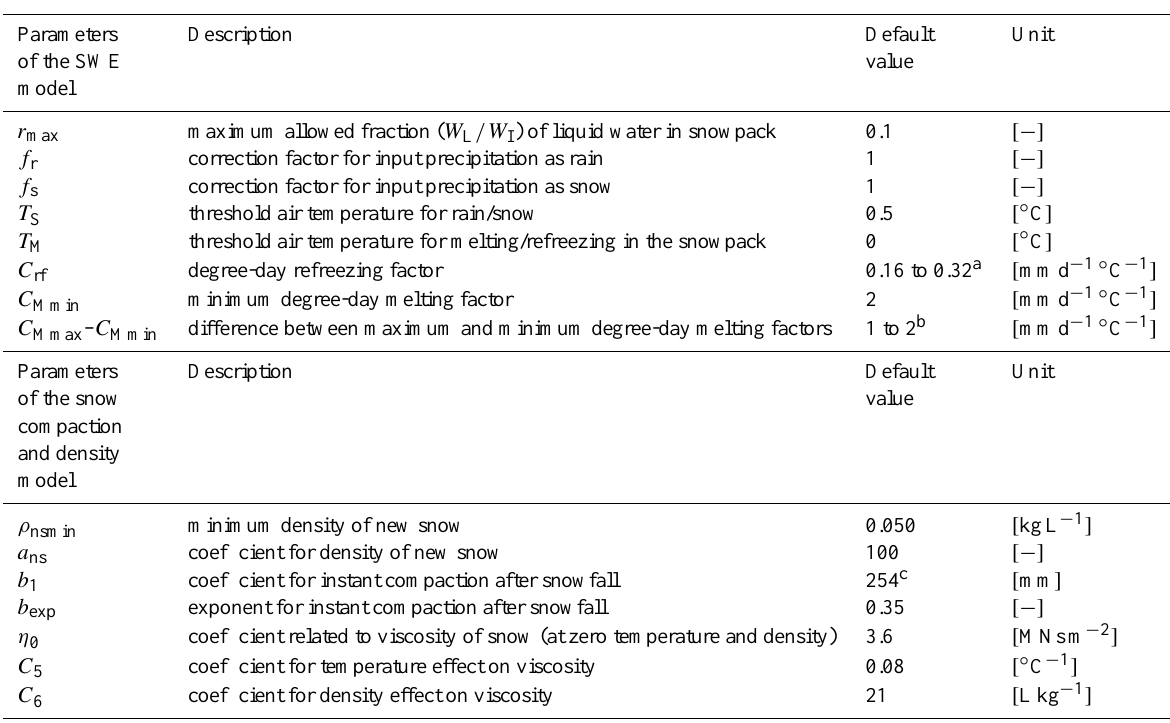
Table 1. The 15 seNorge snow model parameters with their default values and units. The values have been set on the basis of literature, expert judgement as well as model evaluation against observations (see Engeset et al., 2004b). Parameters Description Default Unit of the SWE value model maximum allowed fraction ( W L /W I ) of liquid water in snowpack 0.1 f r correction factor for input precipitation as rain f s correction factor for input precipitation as snow threshold air temperature for rain/snow